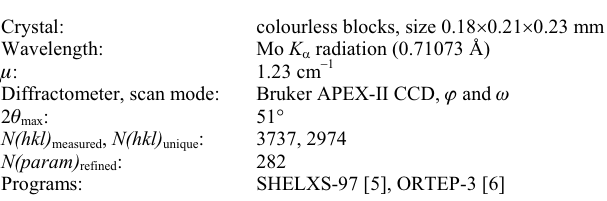
Table 1. Data collection and handling.